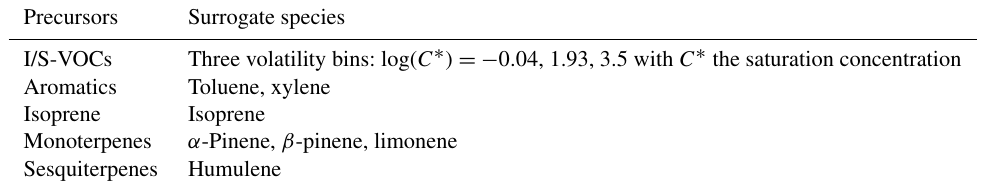
Table 1. Precursors classes and the surrogate species used for SOA formation.